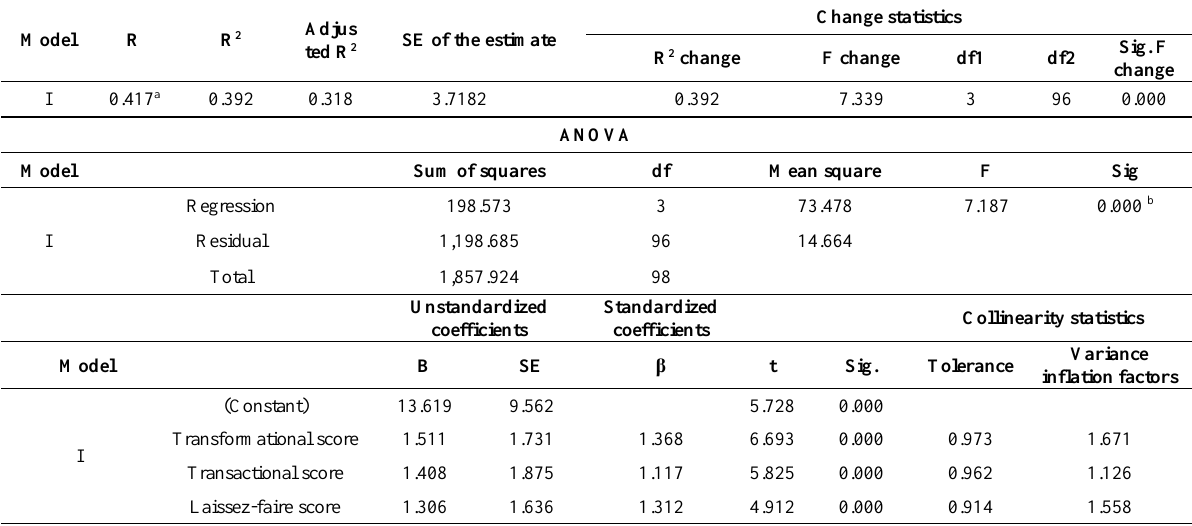
Table 4. Regression of the influence of leadership style on faculty